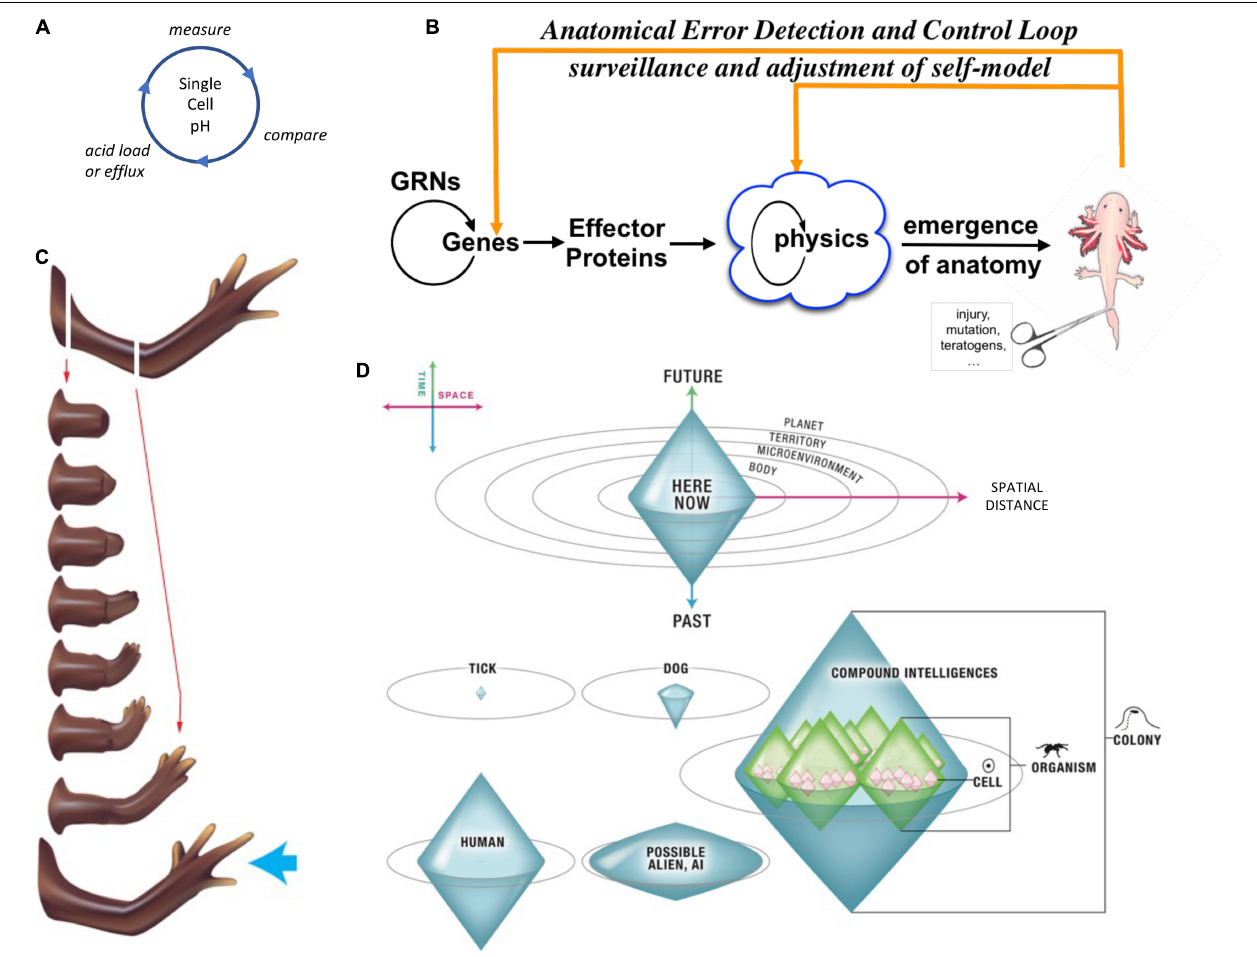
FIGURE 4 | Unconventional goal-directed agents and the scaling of the cognitive Self. (A) The minimal component of agency is homeostasis, for example the ability of a cell to execute the Test-Operate-Exit (Pezzulo and Levin, 2016) loop: a cycle of comparison with setpoint and adjustment via effectors, which allows it to remain in a particular region of state space. (B) This same capacity is scaled up by cellular networks into anatomical homeostasis: morphogenesis is not simply a feedforward emergent process but rather the ability of living systems to adjust and remodel to specific target morphologies. This requires feedback loops at the transcriptional and biophysical levels, which rely on stored information (e.g., bioelectrical pattern memories) against which to minimize error. (C) This is what underlies complex regeneration such as salamander limbs, which can be cut at any position and result in just the right amount and type of regenerative growth that stops when a correct limb is achieved. Such homeostatic systems are examples of simple goal-directed agents. (D) A focus on the size or scale of goals any given system can pursue allows plotting very diverse intelligences on the same graph, regardless of their origin or composition (Levin, 2019). The scale of their goal-directed activity is estimated (collapsed onto one axis of space and one of time, as in Relativity diagrams). Importantly, this way of visualizing the sophistication of agency is a schematic of goal space—it is not meant to represent the spatial extent of sensing or effector range, but rather the scale of events about which they care and the boundary of states that they can possibly represent or work to change. This defines a kind of cognitive light cone (a boundary to any agent’s area of concern); the largest area represents the “now,” with fading efficacy both backward (accessing past events with decreasing reliability) and forward (limited prediction accuracy for future events). Agents are compound entities, composed of (and comprising) other sub- or super-agents each of which has their own cognitive boundary of various sizes. Images by Jeremy Guay of Peregrine